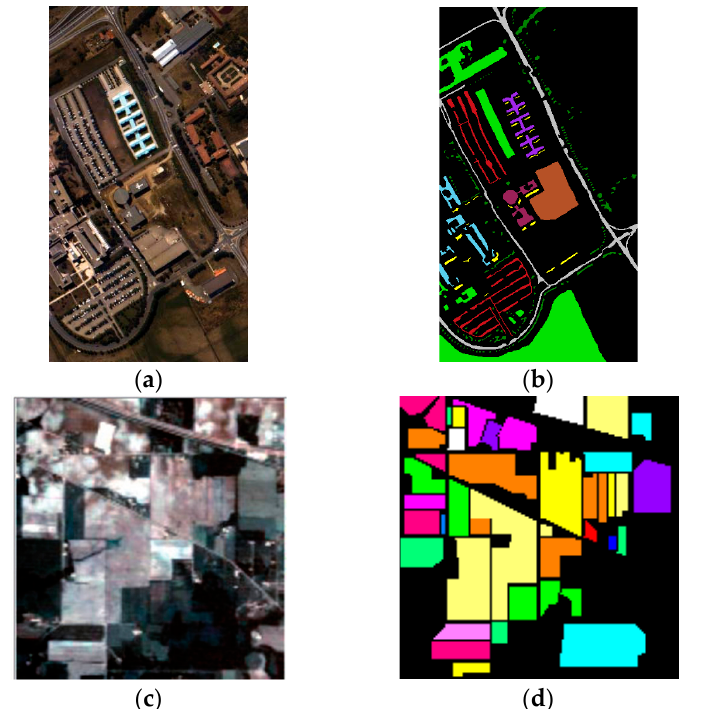
Figure 2. False color representation and corresponding ground truth of ( a , b ) ROSIS-03 University of Pavia dataset, Trees, Asphalt, Bitumen, Gravel, Metal sheets, Shadows, Meadows, Bricks, Bare soil; ( c , d ) AVIRIS Indian Pines dataset, Alfalfa, Corn-notil,